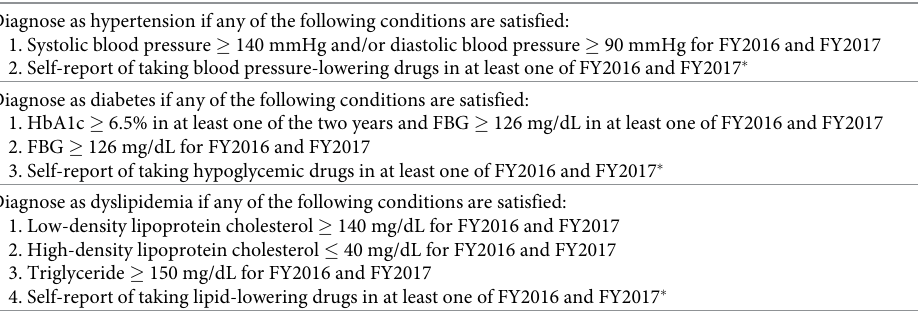
Table 1. Gold standards to diagnose hypertension, diabetes, and